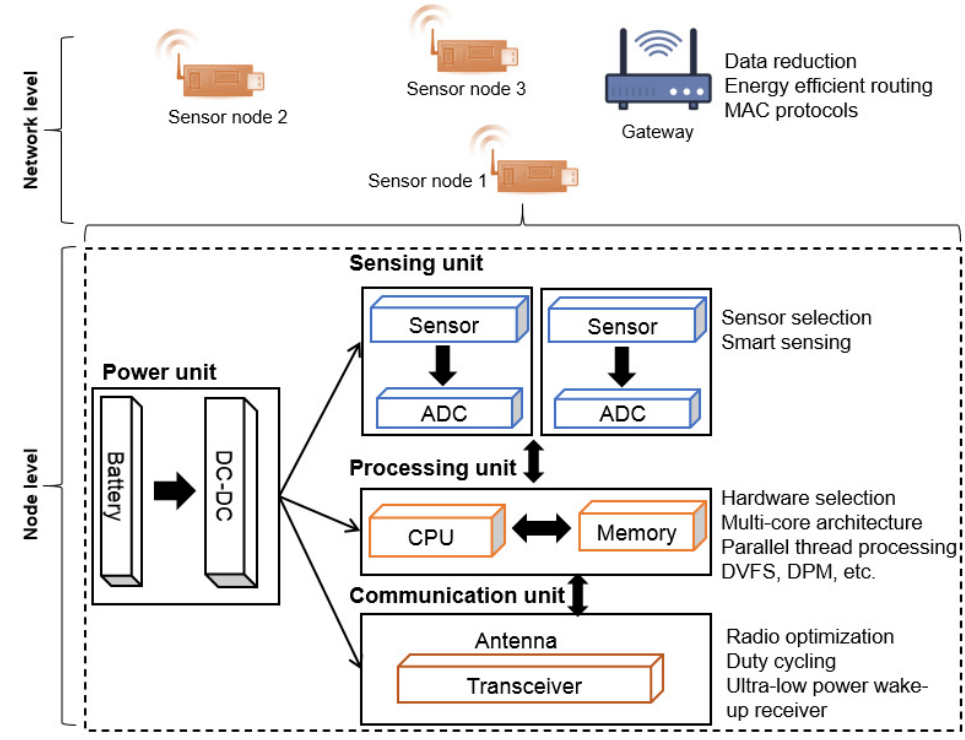
Figure 9. Energy-saving techniques in WSNs.